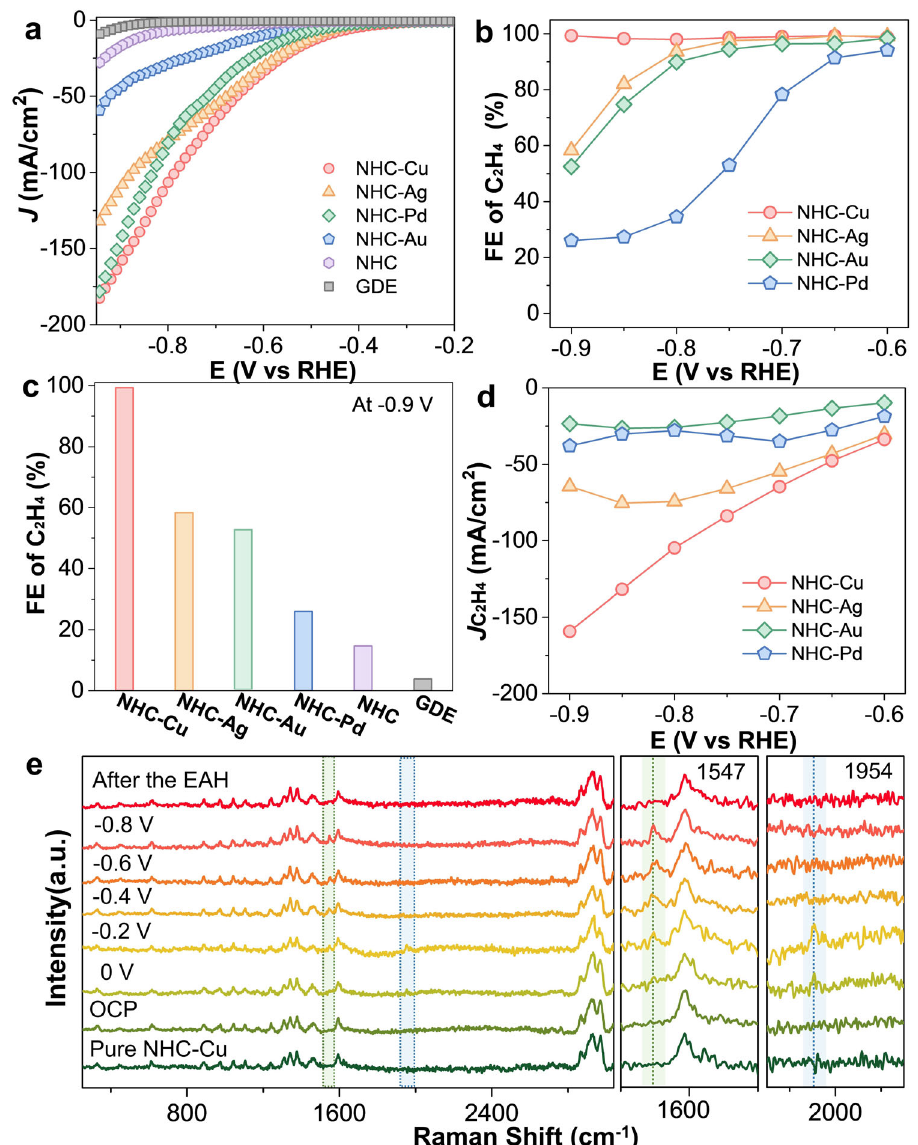
Fig. 2 Experimental investigations of EAH on NHC – metal complexes. a Polarization curves of NHC – metal complexes in a 1 M KOH aqueous solution under pure acetylene fl ow. b Ethylene FEs of NHC – metal complexes in a 1 M KOH aqueous solution at different potentials under pure acetylene fl ow. c Ethylene FEs for NHC – metal complexes, NHC, and gas diffusion electrodes at − 0.9 V vs. reversible hydrogen electrode (RHE) in a 1 M KOH aqueous solution. d Partial current density to ethylene for NHC – metal complexes in a 1 M KOH aqueous solution at different potentials under pure acetylene fl ow. e In situ electrochemical Raman spectra of NHC – Cu in a 1 M KOH aqueous solution. For clarity, the spectral regions of 1500 – 1700 and 1850 – 2150 cm − 1 were